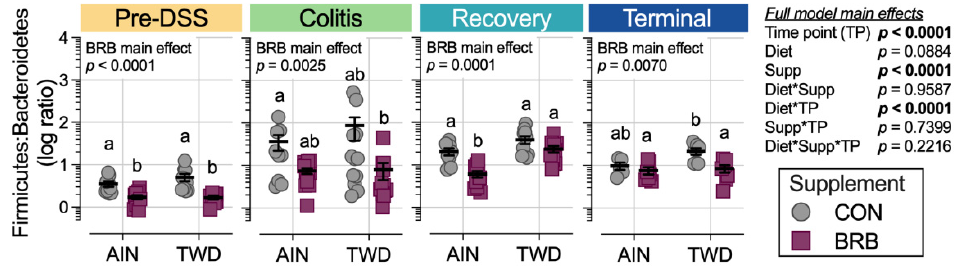
Figure 10. Ratio of Firmicutes to Bacteroidetes for each experimental time point (experiment B). Ratios were determined using normalized count data for each phylum. Data are shown as individual values representing each cage (as the biological unit) with mean ± SE. The table shows the statistical model main effects, including all experimental factors, and different letters indicate that experimental groups are significantly different ( p < 0.05), as determined by statistical methods outlined in the Materials and Methods section.